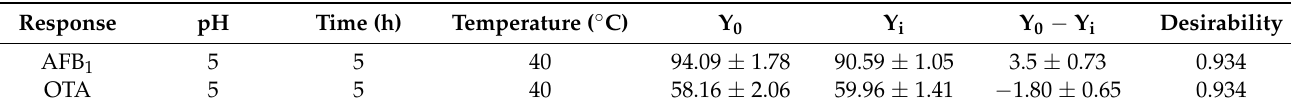
Figure 4. Response optimizer graph showing the predicted optimum point. Table 2. Comparison between experimental and predicted values based on the final reduced models of reduction of mycotoxins with MGO.